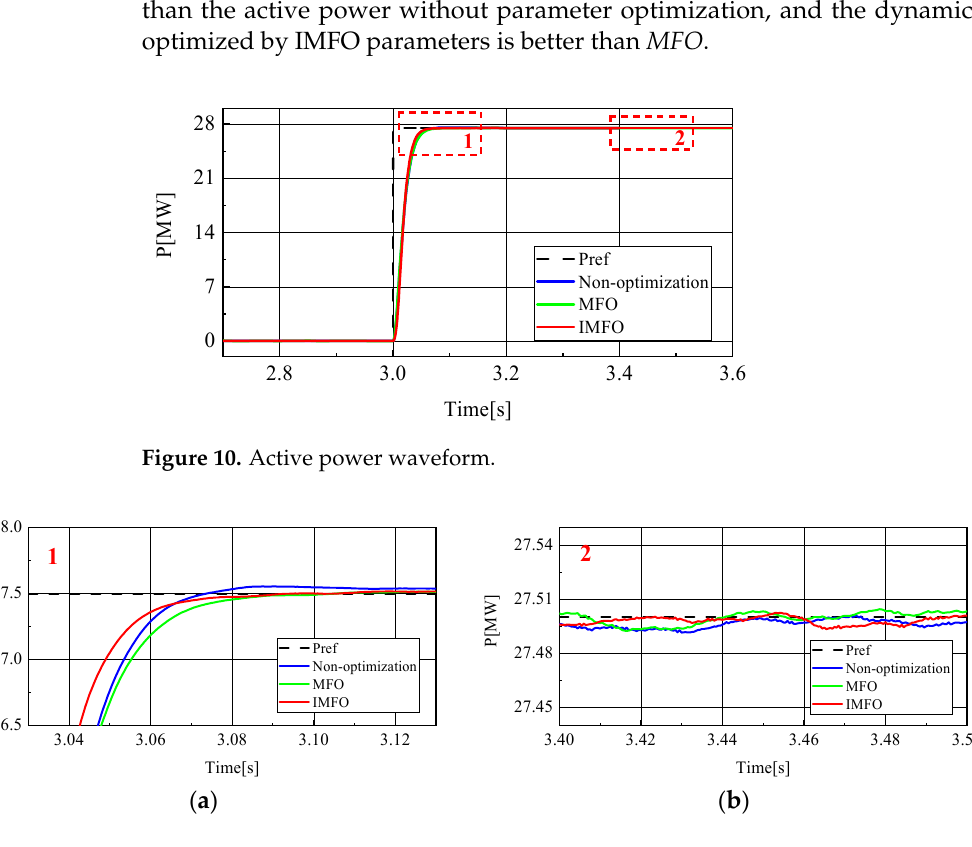
Figure 11. Active power local amplification waveform. ( a ) Locally amplified waveform 1. ( b ) Locally amplified waveform 2.